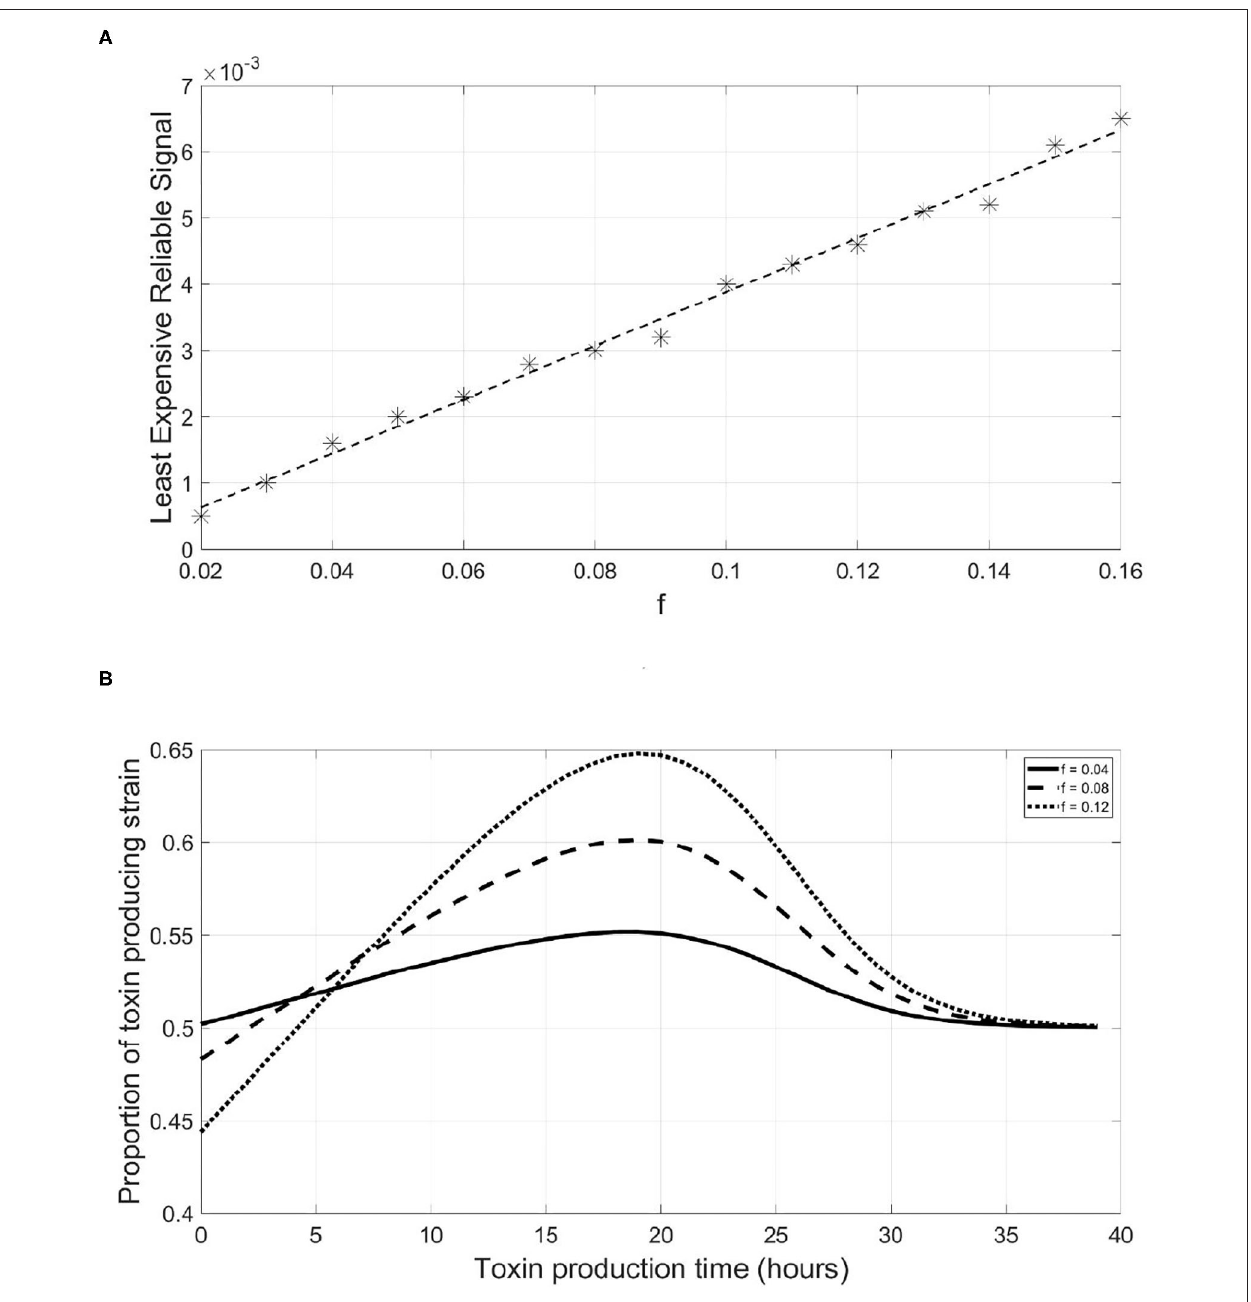
FIGURE 5 | A linear relationship exists between the least expensive reliable signal of a QS toxin producing strain and its fraction of metabolic energy invested in toxin production, which can be explained by the increasing slope of the fitness-toxin production time curve under increasing levels of investment in toxin production. (A) The relationship between the least expensive reliable signal and the fraction of metabolic energy invested in toxin production by a focal QS toxin producing strain. (B) The final fitness of a QS toxin producing strain, expressed as its proportion in the population at the end of a simulation, vs. the time at which toxin production starts by the said strain under different values of the fraction of metabolic energy invested in toxin